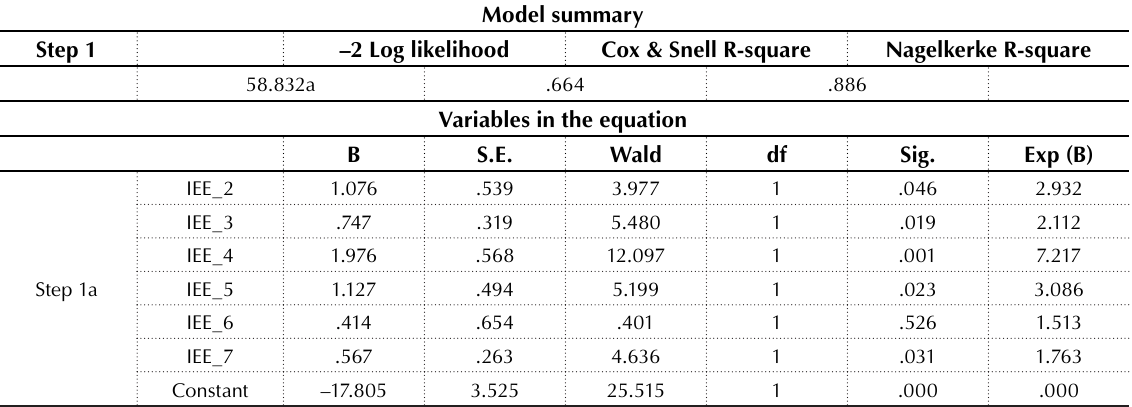
Table 2. Logistic regression analysis on IEE